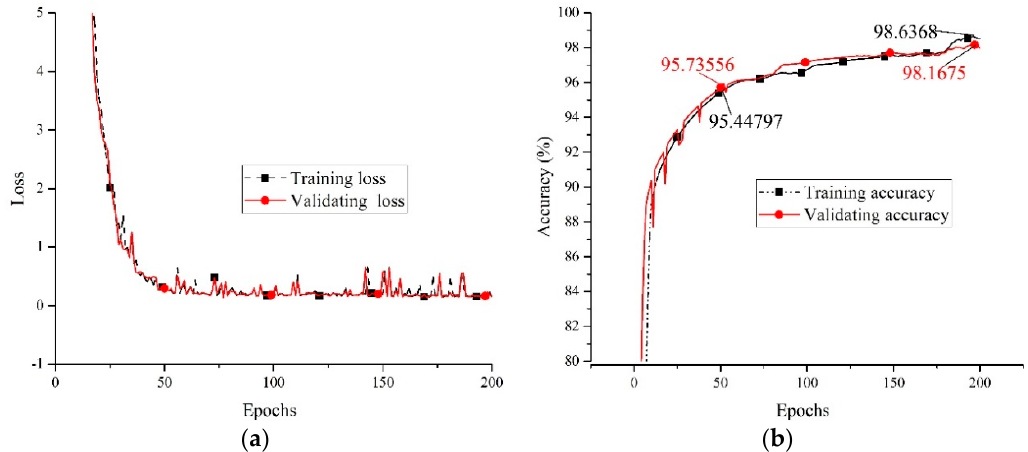
Figure 7. Average loss ( a ) and accuracy curves ( b ) for the training and validation dataset using samples of 128 × 128 pixels in 10 experiments.